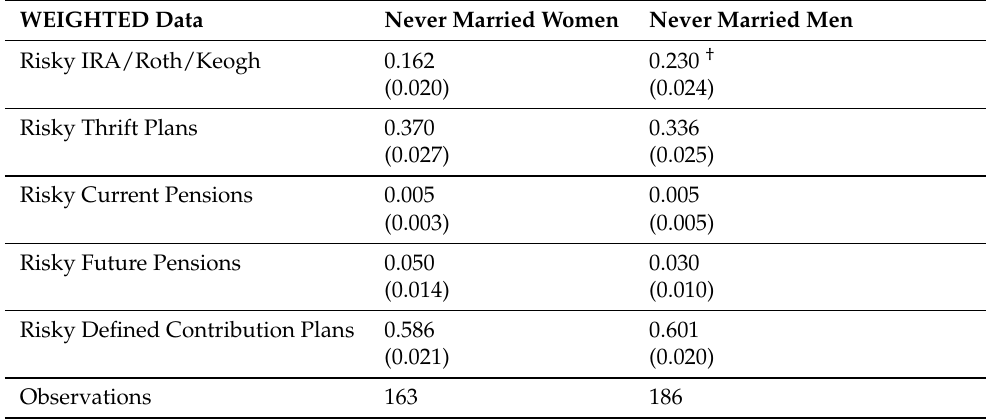
Table 7. Mean Risky Shares of Never Married Females and Never Married Males.